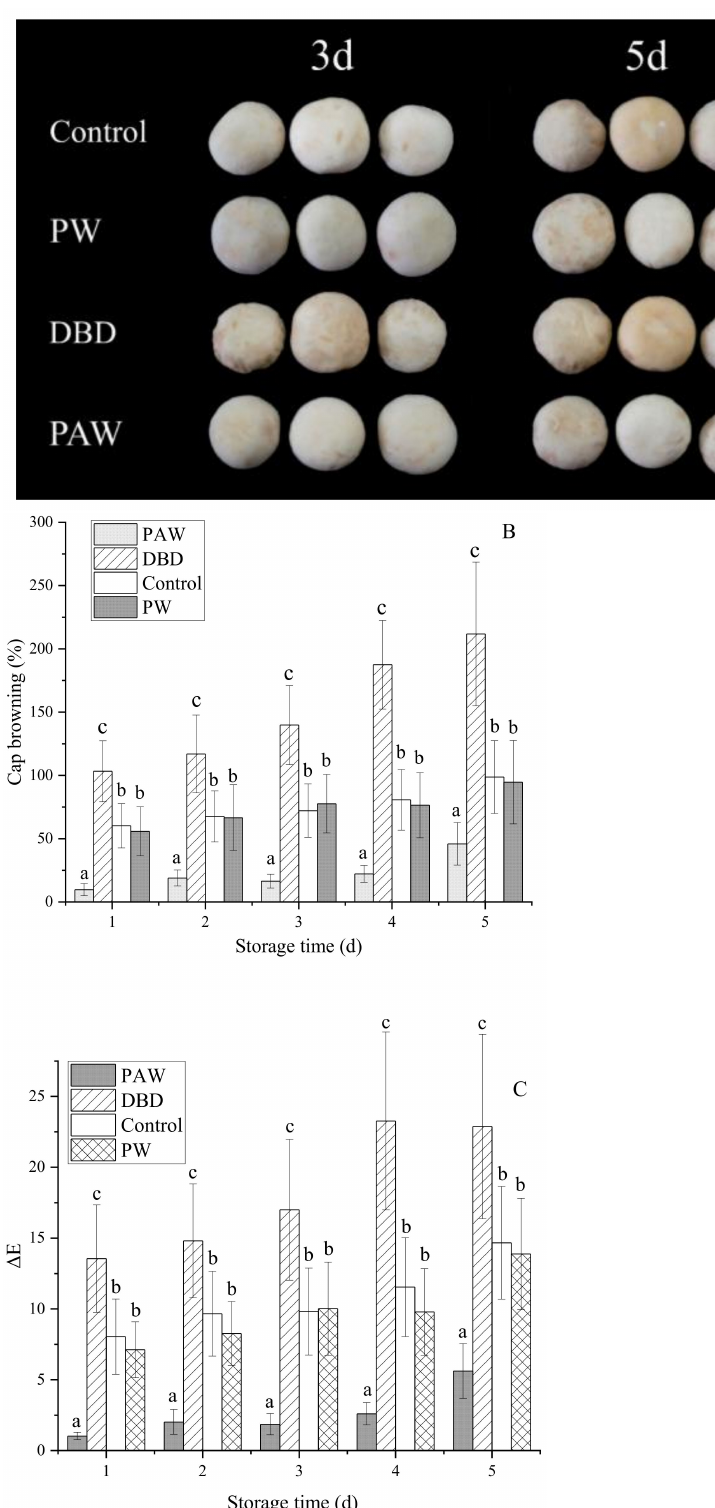
Figure 2. The effect of different treatments on the ( A ) visual quality, ( B ) BI, and ( C ) ∆ E of the button mushrooms. Each value is expressed as a mean ± SD. Different letters indicate significant differences ( p <